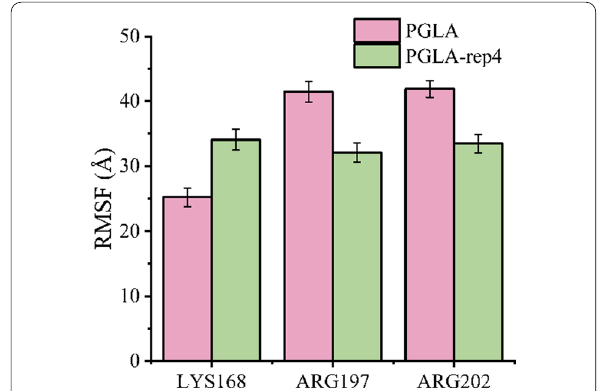
Fig. 6 RMSF values of PGLA and PGLA‑rep4 at three key catalytic